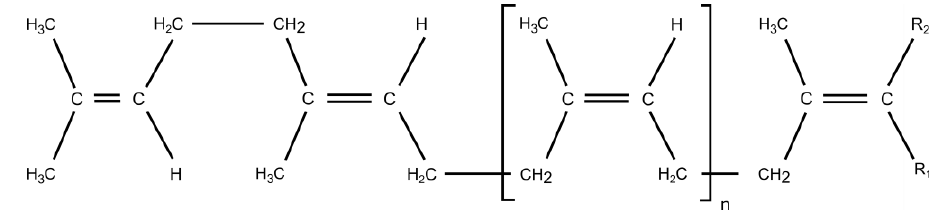
Figure 7. Overview of broad chemical structure of natural polyisoprene ( cis -1,4 units).